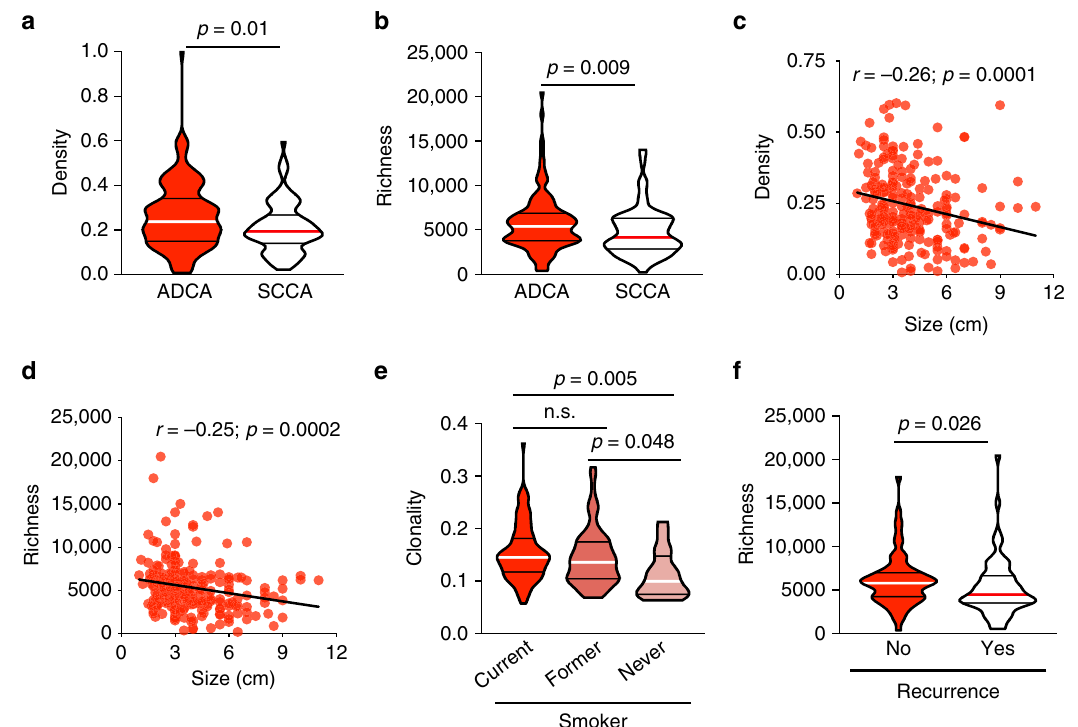
Fig. 4 The T cell repertoire is associated to clinicopathologic attributes. a T cell density in adenocarcinomas ( n = 135) and squamous cell carcinomas ( n = 89). ( b ) T cell richness in adenocarcinomas ( n = 134) and squamous cell carcinomas ( n = 89). c Correlation between T cell density or ( d ) richness and tumor size ( n = 225). e T cell clonality in current ( n = 101), former ( n = 107), and never smokers ( n = 16). f T cell richness in relapsed ( n = 70) versus non-relapsed ( n = 64) adenocarcinoma patients. Bars represent median and